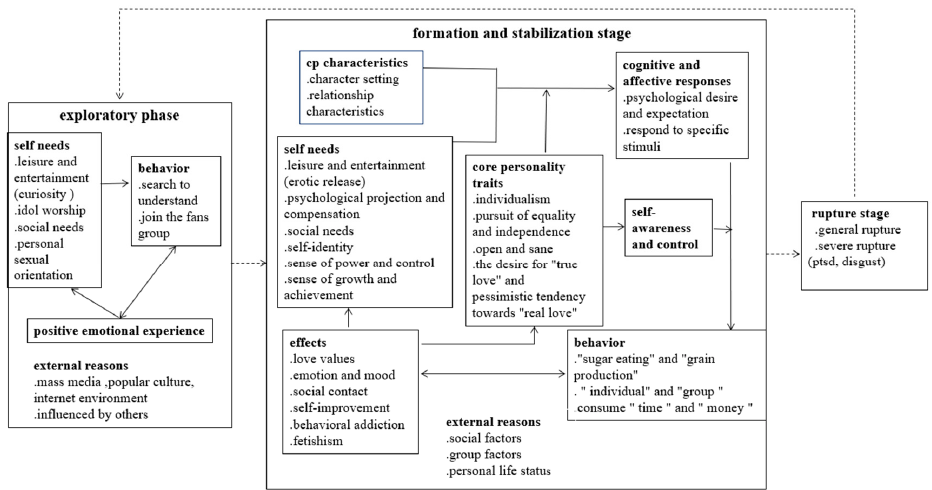
Figure 1. Generation, development, and consequences of shipping. The dotted lines indicate the phases that may be experienced. Table 2. Three categories of shipping development.